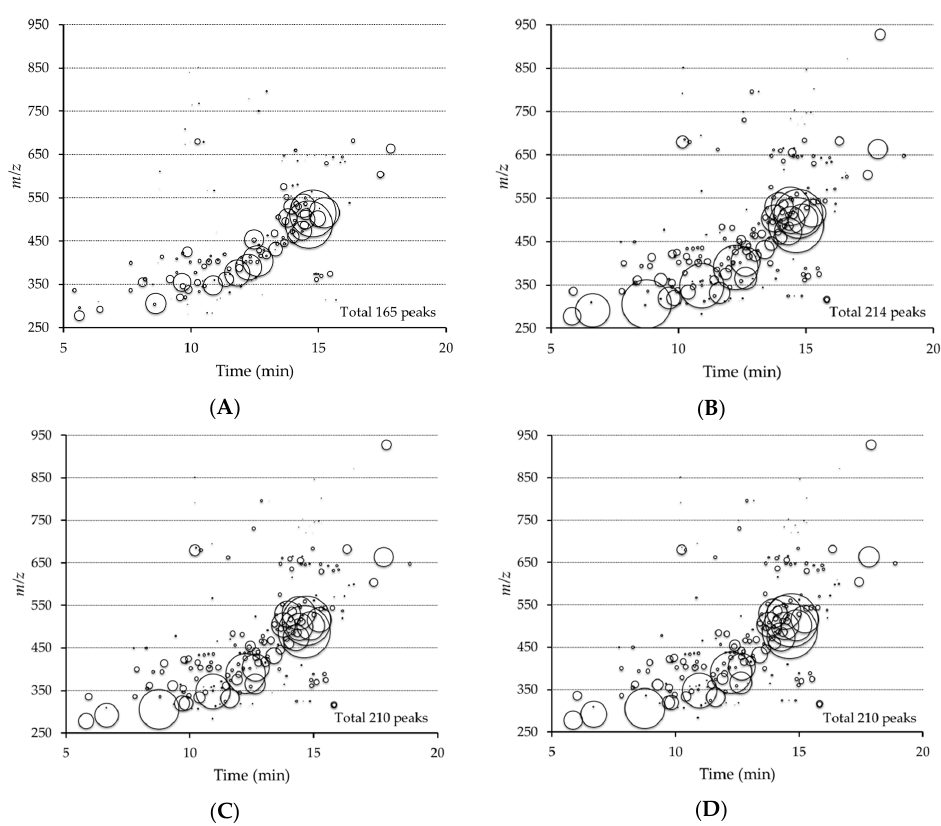
Figure 4. Reactive carbonyl species (RC) maps of cerebral cortices obtained from SAMP10 mice in the ( A ) YC, ( B ) OC, ( C ) OS0.02, and ( D ) OS0.05 groups. Experimental groups are indicated as: Young control, fed basal diet (YC), old control, fed basal diet (OC), old, fed basal diet supplemented with 0.02% sesame lignans (OS0.02), and old, fed diet supplemented with 0.05% sesame lignans (OS0.05). The area of each circle represents the relative intensity of the RCs compared to an internal standard. RC maps are presented as averages of each map ( n = 5).